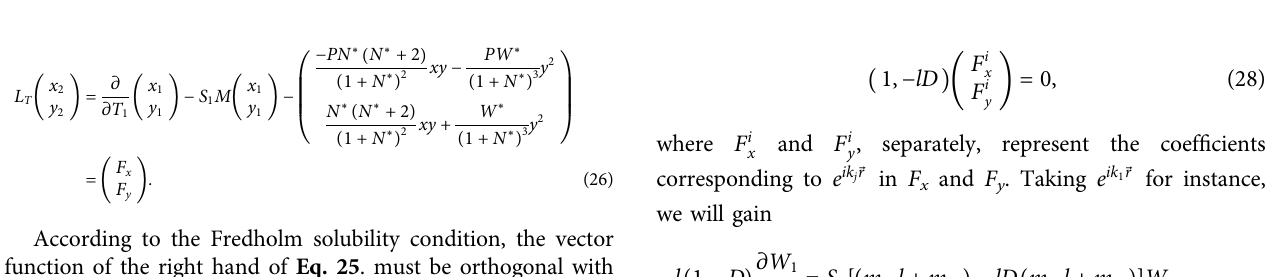
FIGURE 4 | Snapshots of the countour pictures of evolution of vegetation with different values of P , (A) p (cid:1) 0.14286; (B) p (cid:1) 0.15; (C) p (cid:1) 0.16; (D) p (cid:1) 0.18; (E) p (cid:1) 0.21; (F) p (cid:1) 0.22. The other parameters are taken as S (cid:1) 10, B (cid:1) 5, and D (cid:1) 30.